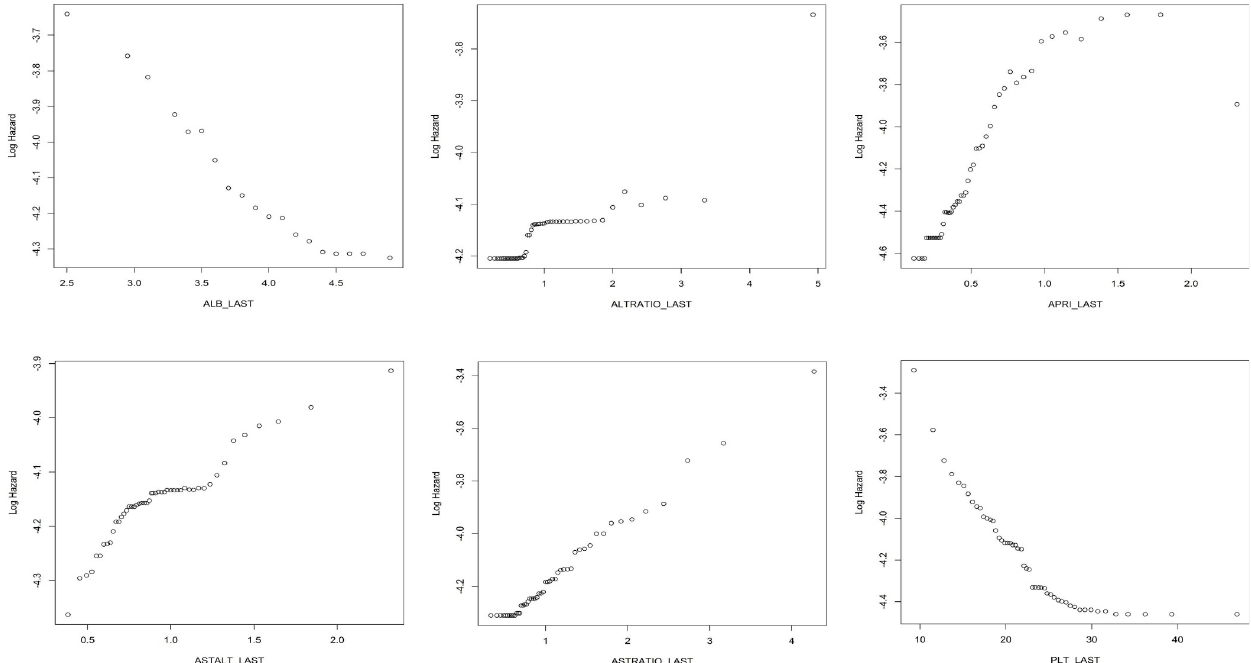
Fig 5. Partial dependence plots for the cross-sectional boosting